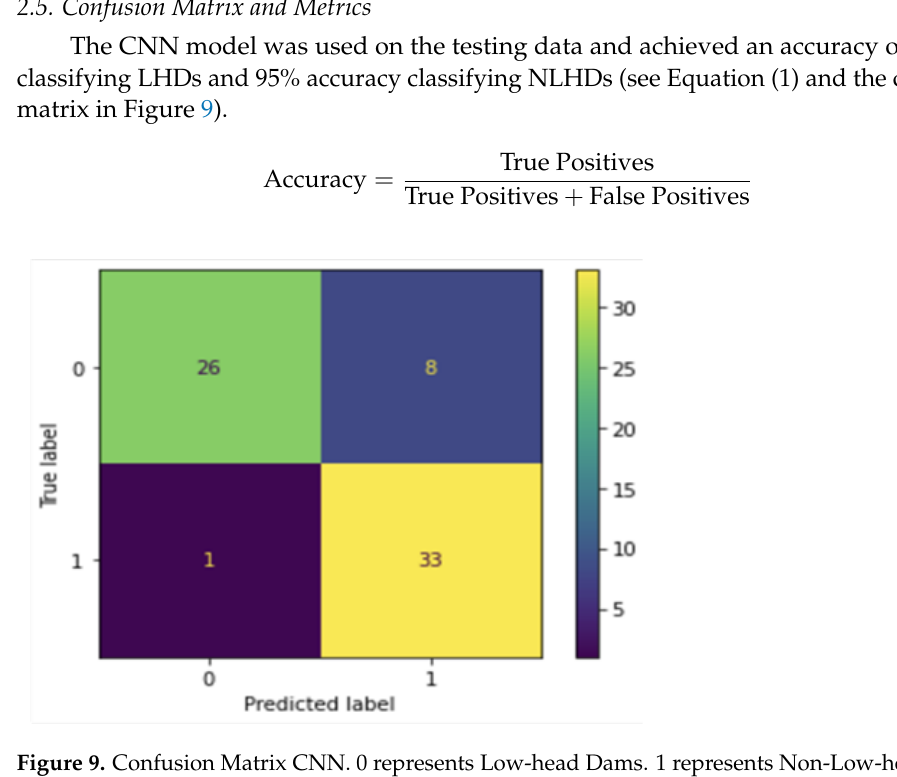
Figure 9. Confusion Matrix CNN. 0 represents Low-head Dams. 1 represents Non-Low-head Dams.